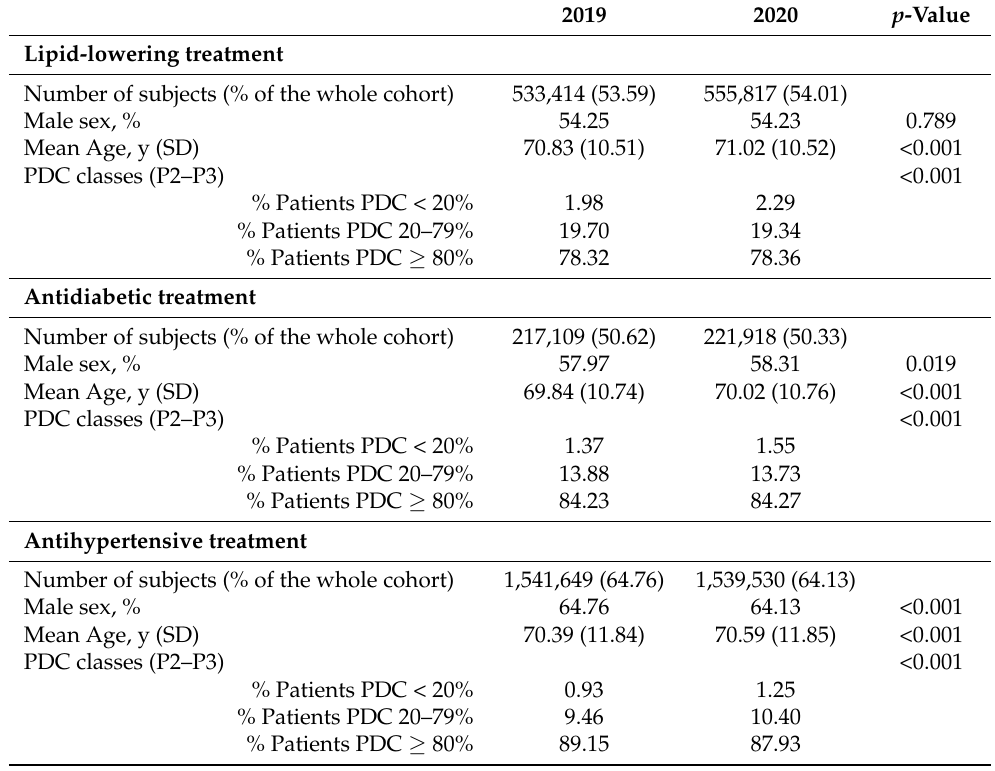
Table 1. Characteristics of subjects with high adherence (PDC ≥ 80%) at the end of the period P1, for each year and by the three chronic therapies.